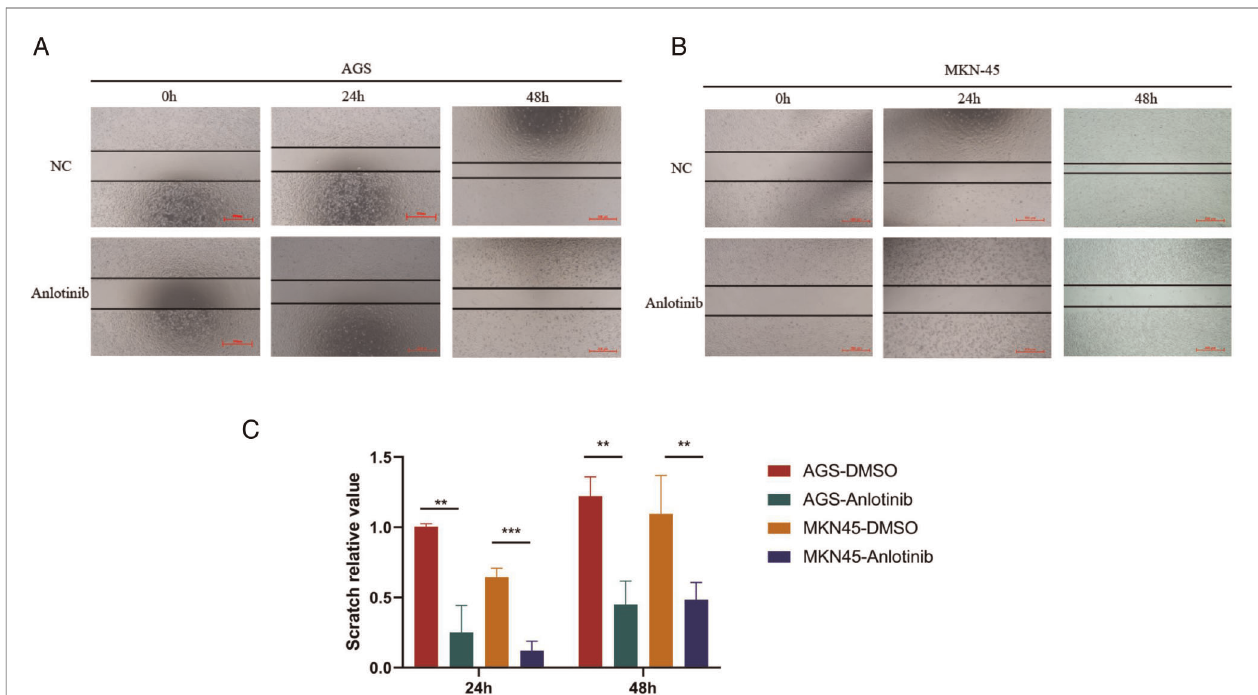
FIGURE 6 | Scratch test results of Anlotinib in GC cells. ( A – C ) Scratch assay proved that Anlotinib can inhibit the migration of GC cells. * P <0.05; ** P <0.01; *** P